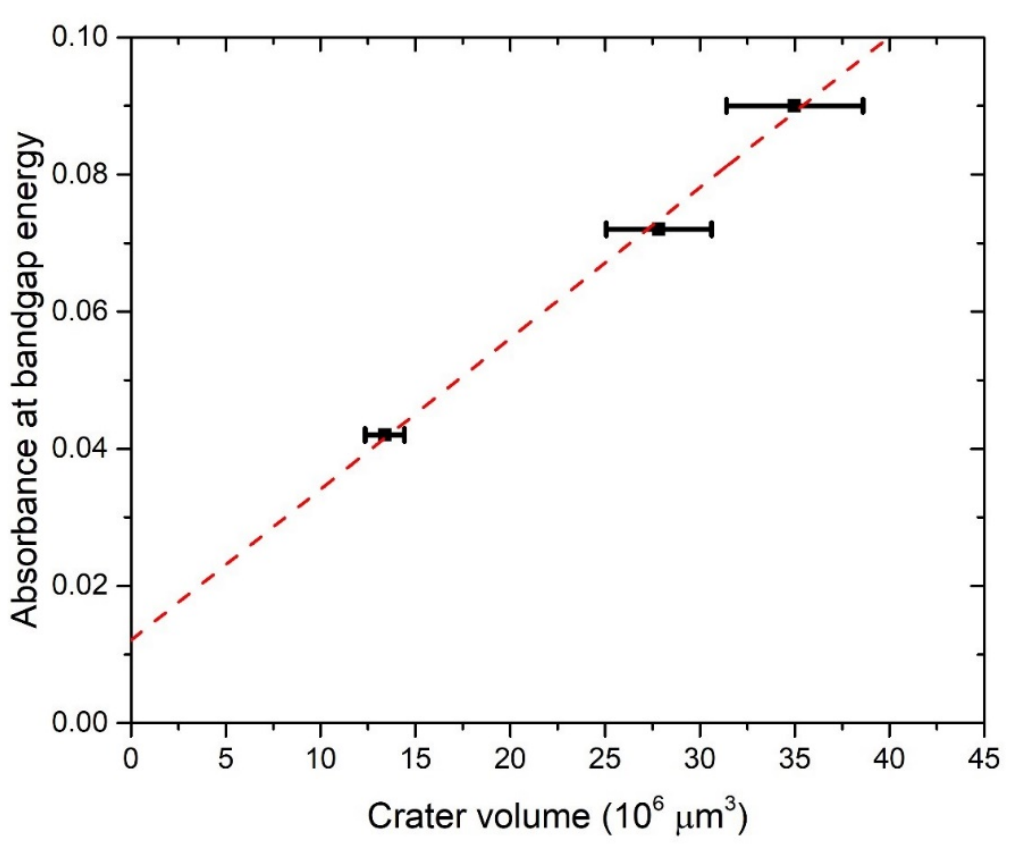
Figure 6. The absorbance at the wavelength corresponding to the bandgap energy vs. the crater volume for TiO 2 colloidal solution synthesized with PLAL. Linear fit.